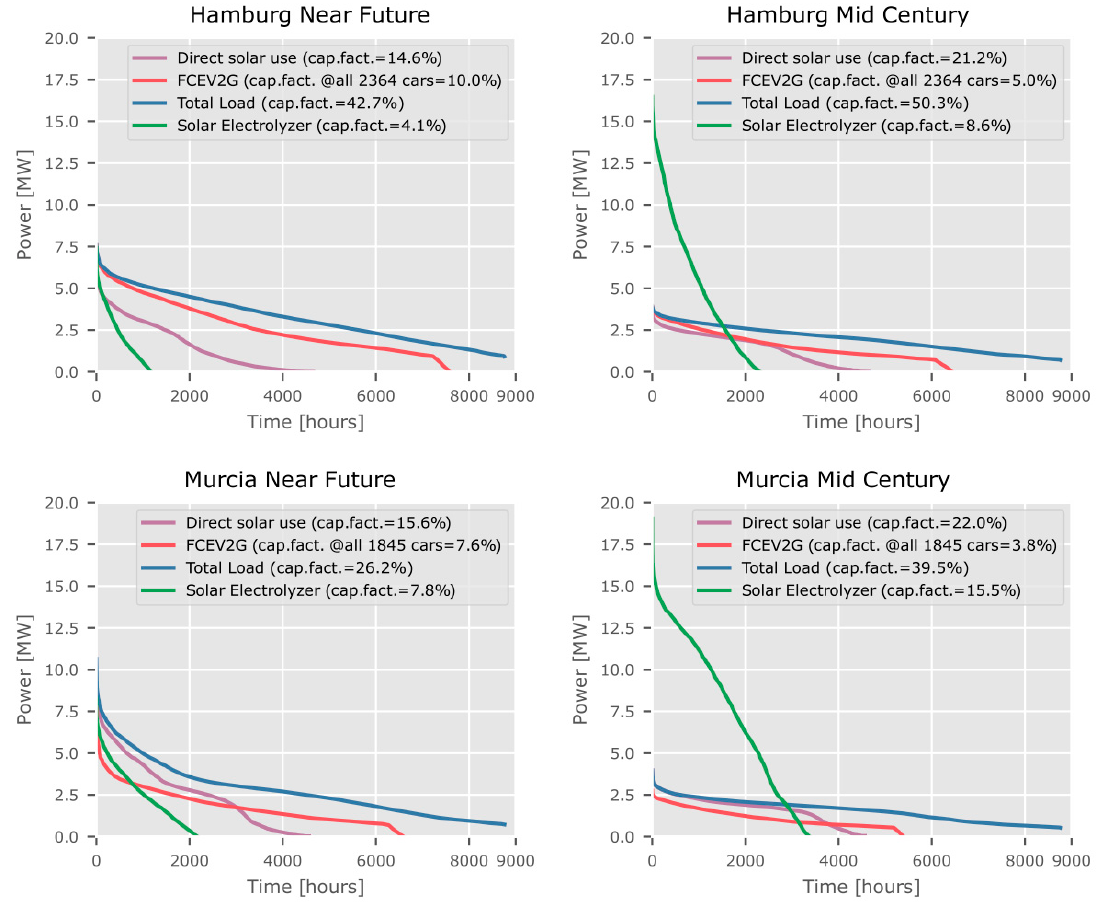
Figure A1. Load duration curves for the simulation, based on 2016 weather data for Hamburg ( top ) and Murcia ( bottom ) for the Near Future ( left ) and Mid Century scenarios ( right ). Direct solar use (purple), FCEV2G electricity (red), combined FCEV2G and direct solar use (blue), and the solar electrolyzer power consumption (green).